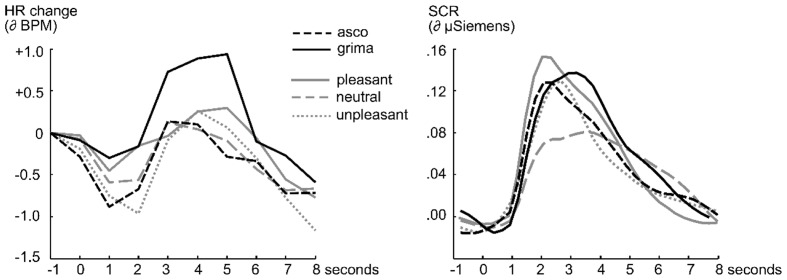
Changes in heart rate (HR, left) and skin conductance response (SCR, right) during the presentation of disgust, grima, pleasant, unpleasant, and neutral sounds (Study 3). HR changes are represented in beats per minute (bpm) in 0.5 s bins intervals, while the SCR was calibrated to detect activity in the range of 0–40 micro-Siemens (μS). The time series cover the duration of the sound presentations and include a second prior to sound onset.